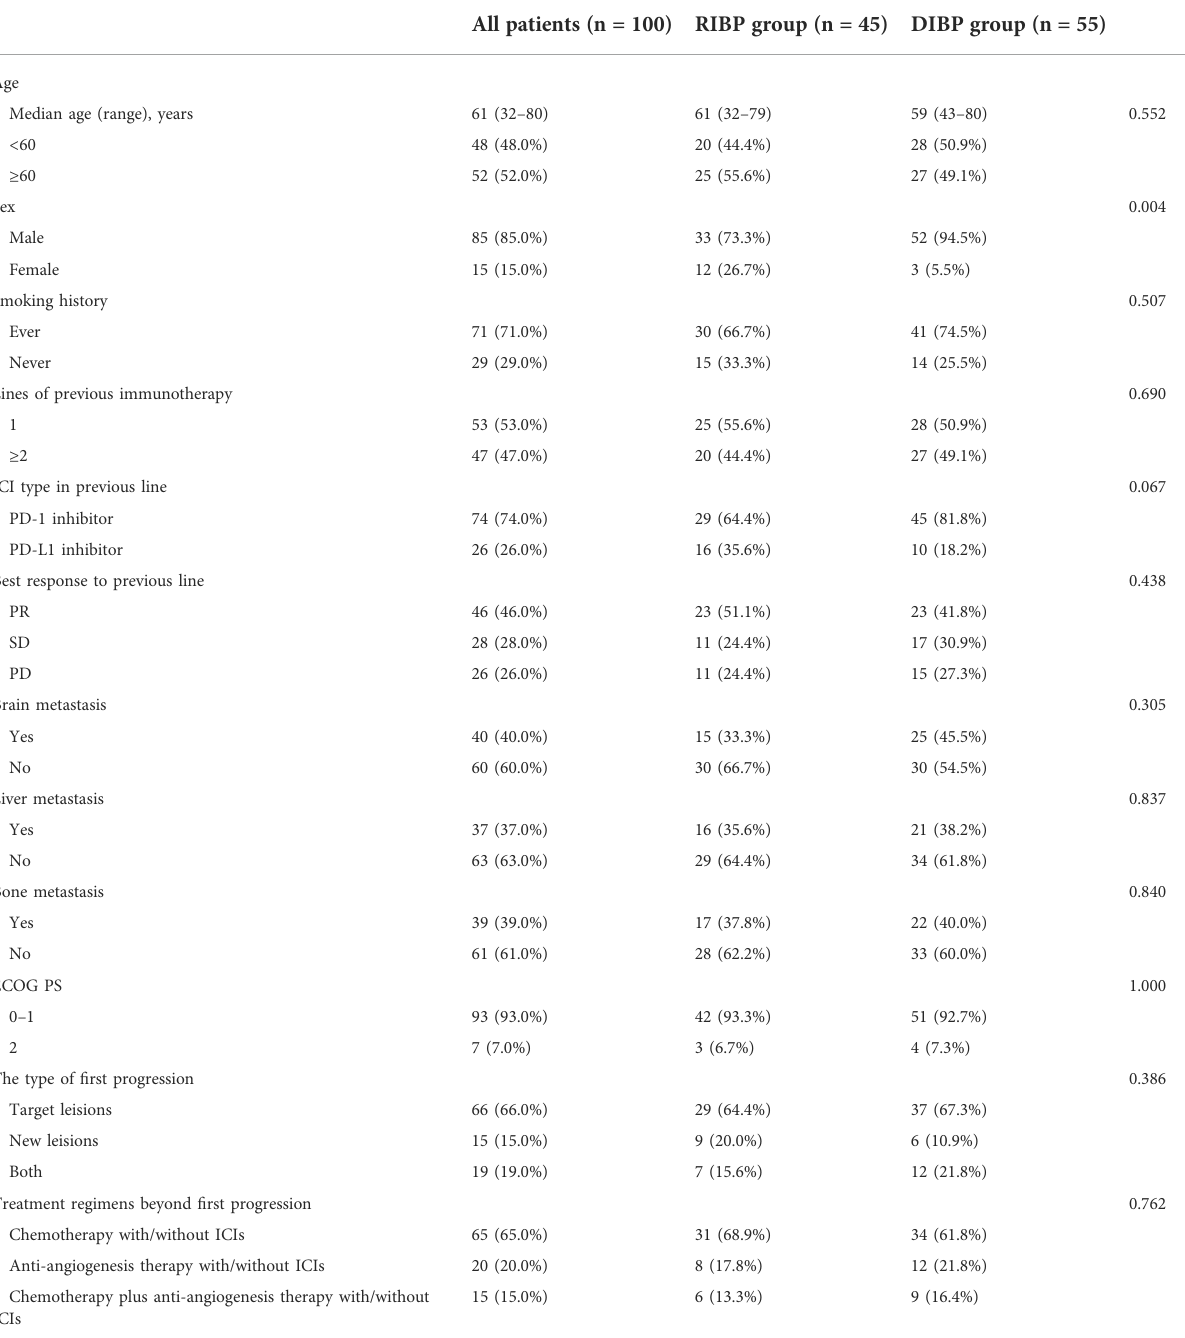
TABLE 1 Baseline characteristics of the patients.